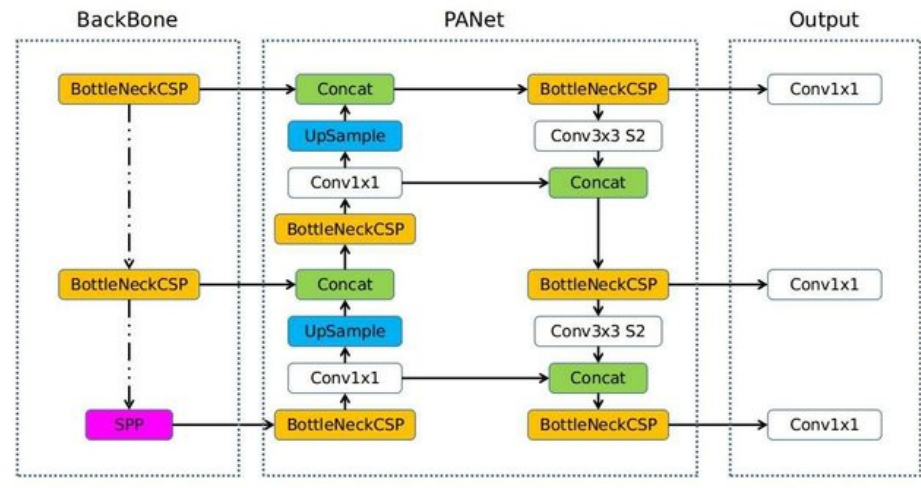
Figure 8. YOLOv5 model architecture [30].